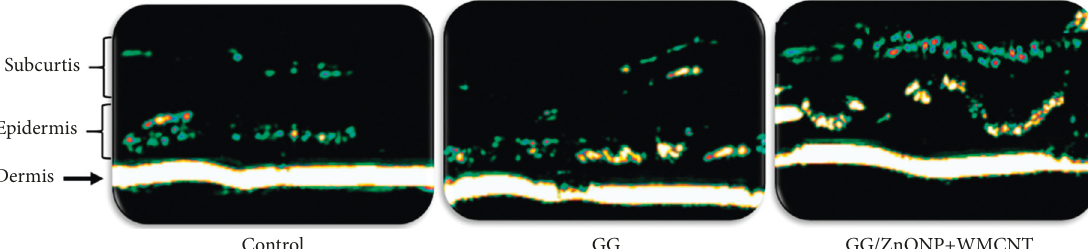
Figure 10: Ultrasound images of healed wound area on Sprague Dawley rats treated with (a) control, (b) GG, (c) GG/ZnONP + WMCNT on day